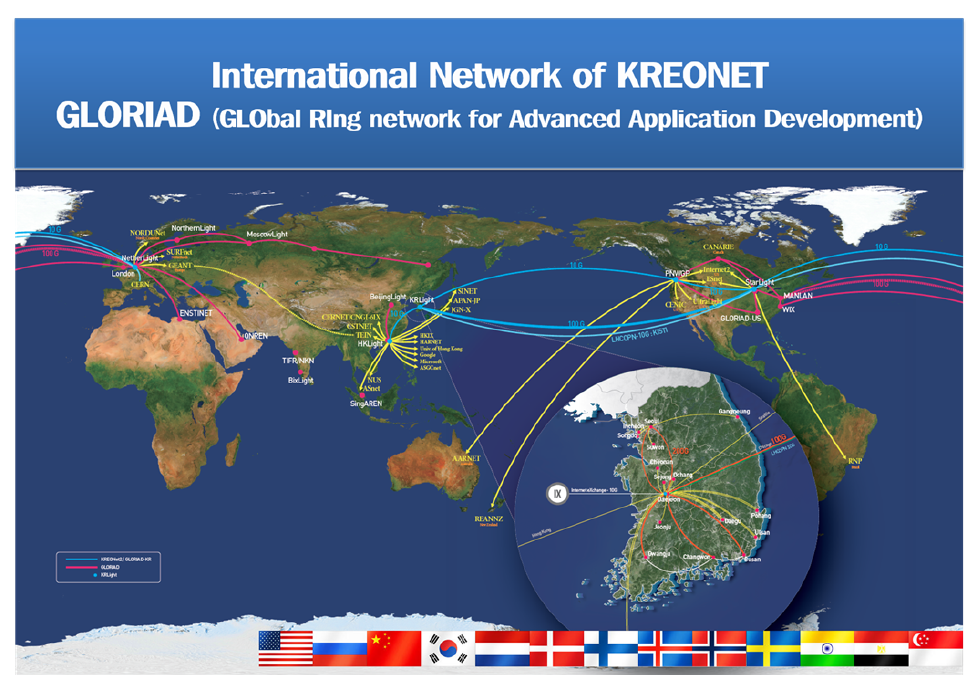
Figure 4. International network map of GLORIAD